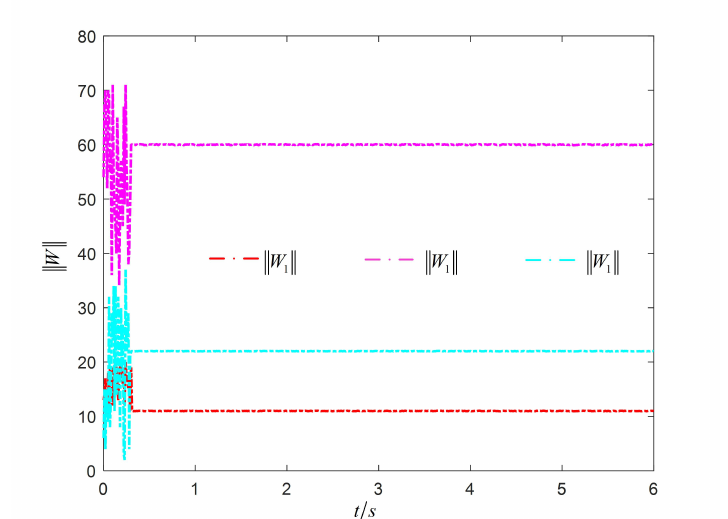
Figure 4. The optimal weight value of the neural